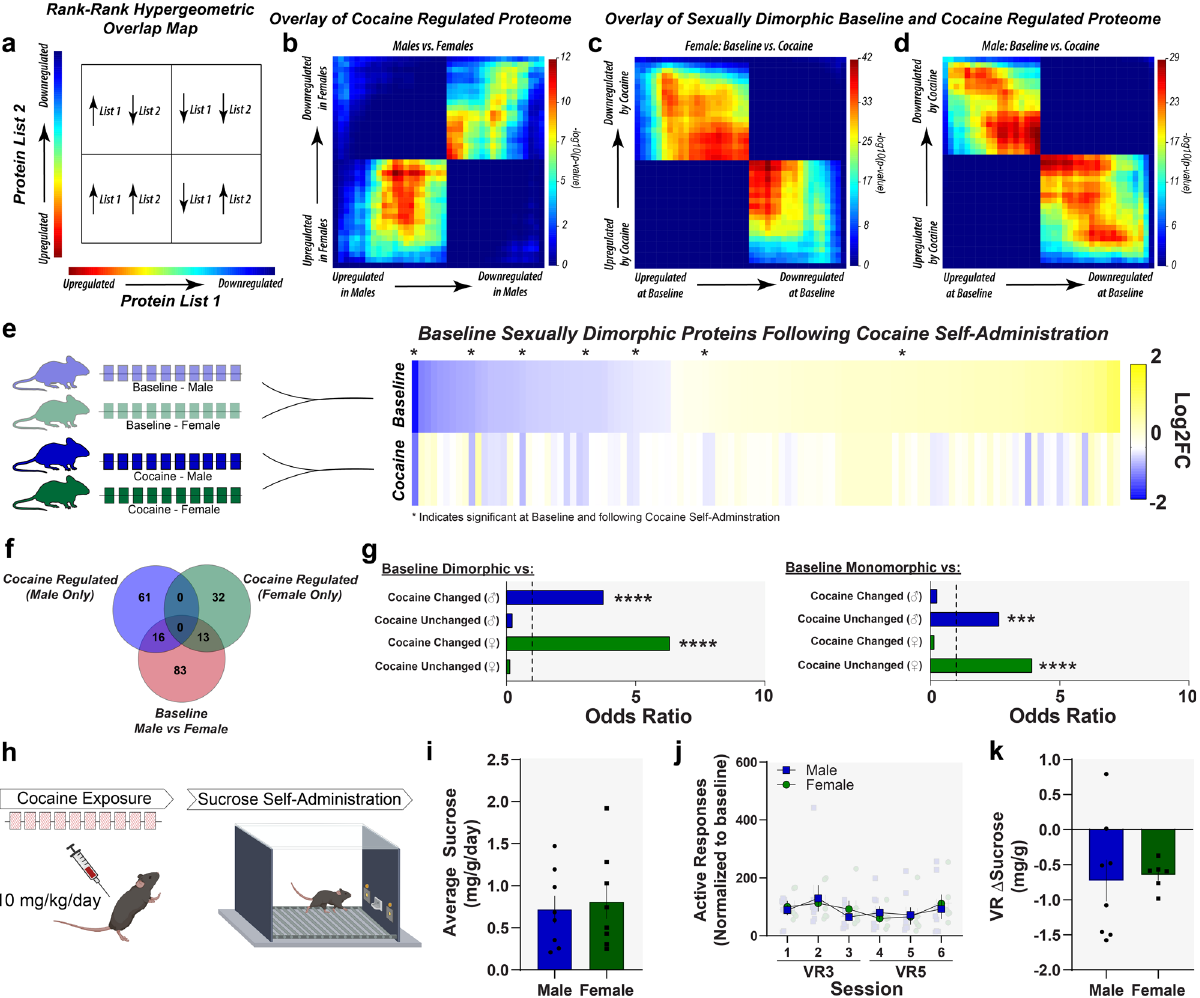
Fig. 5 Cocaine exposure eliminates baseline sexual dimorphisms in the proteome and behavior. a Rank – rank hypergeometric overlap (RRHO) plots allow for threshold-free comparisons in proteomic expression between two differential expression lists. b Cocaine-induced proteomic regulation (cocaine versus saline controls) in males and females was compared. There was some overlap between the cocaine-regulated proteins between males and females. c Cocaine had a much different regulation pattern for the baseline sexually dimorphic proteins than the rest of the proteome. RRHO plot showing the comparison between the proteins that were increased/decreased in females at baseline ( x -axis) and the proteins following cocaine self-administration (female cocaine versus female saline). There was signi fi cant opposite regulation by cocaine in these proteins suggesting that cocaine increased downregulated and decreased upregulated sexual dimorphisms in females. d The same pattern was seen in males. RRHO plot showing cocaine-regulated proteins (cocaine versus saline controls) proteins that were increased/decreased in males at baseline. f Heat map comparing male and female proteomes at (top) baseline and (bottom) following cocaine. Of 112 proteins differentially expressed between males and females at baseline, only 7 (asterisk) are also signi fi cantly different between males and females following cocaine, suggesting that cocaine exposure eliminates these sexual dimorphisms. f Venn diagram of proteins regulated by cocaine in males (blue), regulated by cocaine in females (green), and differentially expressed between males and females at baseline (red). Proteins regulated by cocaine in both males and females appear to show enrichment in sexually dimorphic population at baseline. g (Left) Fisher ’ s exact test of odds ratio for protein overlap of cocaine-regulated proteome in males and females compared to proteomic differences at baseline. g (Right) Fisher ’ s exact test of odds ratio of cocaine-regulated proteome in males and females compared to sexually monomorphic proteins at baseline. Proteins that were sexually dimorphic at baseline were more likely to be regulated by cocaine than proteins that were not. h Lastly, we wanted to understand how cocaine exposure altered sexually dimorphic behaviors that are known to be controlled by the NAc. Therefore, we assessed how chronic cocaine pretreatment prior to sucrose self-administration altered behavior. i Average daily sucrose consumption in mg between male and female mice, normalized to body weight. There is no signi fi cant difference in sucrose consumption between males and females. j Average responses for sucrose under VR3 and VR5 between male and female mice, normalized to baseline (responses during fi rst day of VR3), showing no sex differences. k Average change in sucrose consumption from VR3 to VR5, normalized to body weight. Male and female mice show comparable schedule-dependent changes in sucrose consumption, indicating that cocaine exposure eliminates sexually dimorphic behavior associated with nondrug reinforcers. All behavior data reported as mean±SEM. * p <0.05, *** p <0.001, **** p <0.0001. Diagrams created with